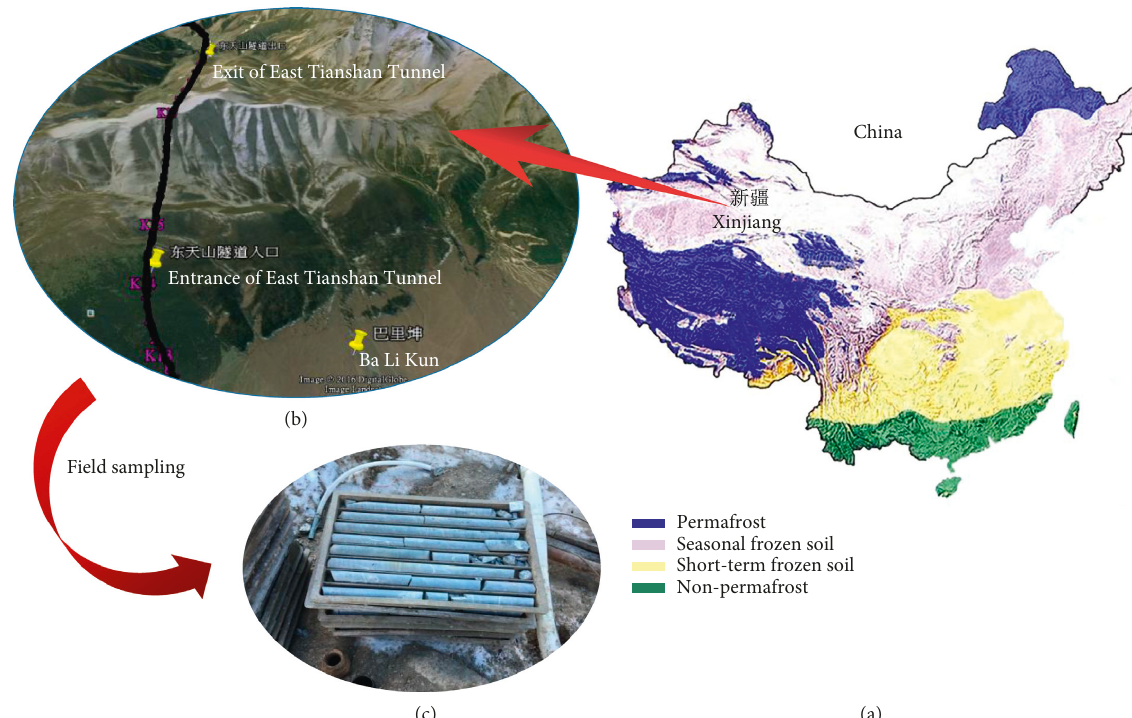
Figure 1: (a) Map of permafrost distribution in China. (b) Location of the study area. (c) Some rock